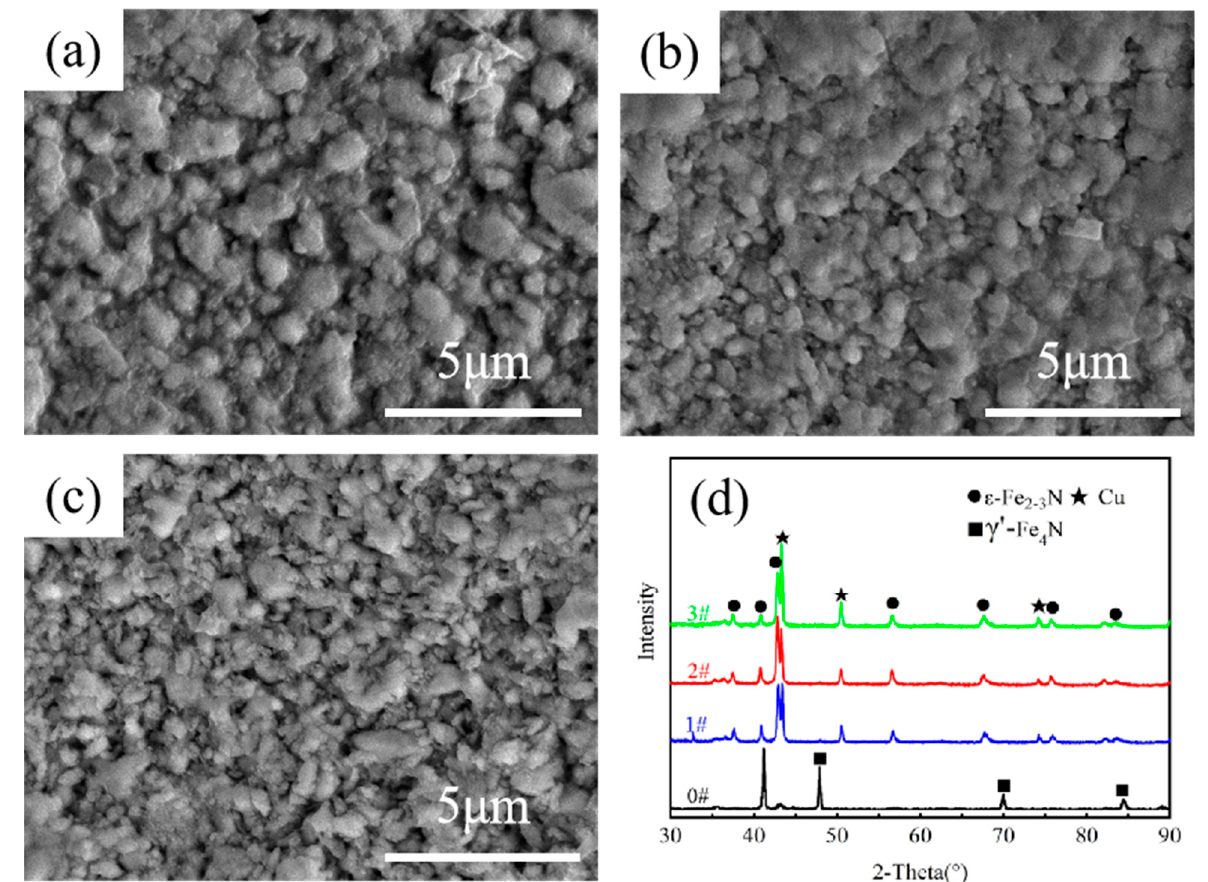
Figure 5. Microscopic morphologies of nano-Cu/microalloyed gradient coating. ( a ) 1#, ( b ) 2#, ( c ) 3#, and ( d ) their X-ray diffraction patterns. Table 3. Chemical compositions of nano-Cu/microalloyed gradient coating on 42CrMo surface af- ter in situ nitriding process (wt. %).